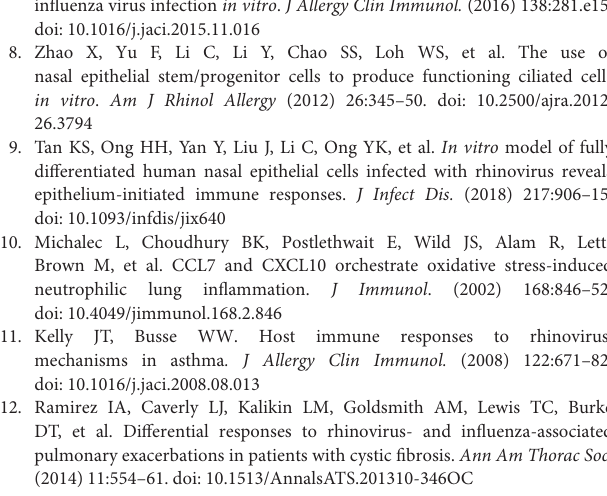
Supplementary Figure 1 | Flow cytometry gating strategy. Supplementary Figure 2 | Flow cytometric analysis of NK cell sub-populations after co-culture with influenza-infected epithelium. Gating strategy for NK cells in PBMC (A) . CD38 up-regulation in CD16 + CD56dim (pink), CD16- CD56dim (light blue), and CD16- CD56hi (dark blue) NK cells after PBMC co-culture with influenza-infected epithelium for 24h (B) . Gating strategy for purified NK cells (C) . CD38 up-regulation in CD16 + CD56dim (pink), CD16- CD56dim (light blue), and CD16- CD56hi (dark blue) after isolated NK cells co-cultured with influenza-infected epithelium for 24h. Values in the histograms are the geometric mean of CD38 expression level. Supplementary Figure 3 | Heatmap of the 23 analytes measured by Luminex at 24h and 48h for PBMC, uninfected epithelium with PBMC (Mock), and influenza-infected epithelium with PBMC (IAV). The colors indicate the relative change (log2 fold change) of analyte concentration from each donor in the supernatant of PBMC, Mock, and IAV infection at 24h and 48h compared to PBMC at 24h. For each analyte, the relative concentration is shown as a scale from 15 and − 10. Supplementary Figure 4 | Summary of CD38 and CD69 upregulation of various immune cells measured by flow cytometry for PBMC only, uninfected epithelium with PBMC, and influenza-infected epithelium with PBMC cultured for 24h (A) and 48h (B). All data represent the mean ± SD. ∗∗∗ , P < 0.001; ∗∗ , P < 0.01; ∗ , P < 0.05; ns, not